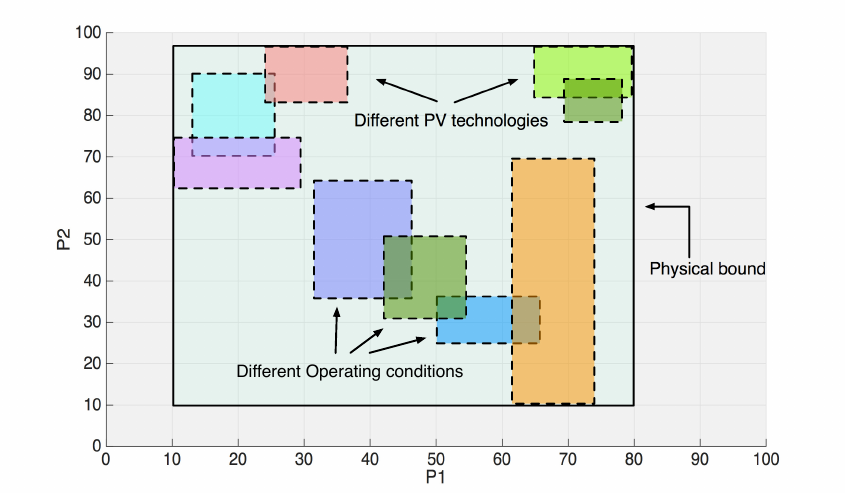
Figure 3. The difference of physical boundary conditions (continuous box) and real boundary conditions (dashed boxes).